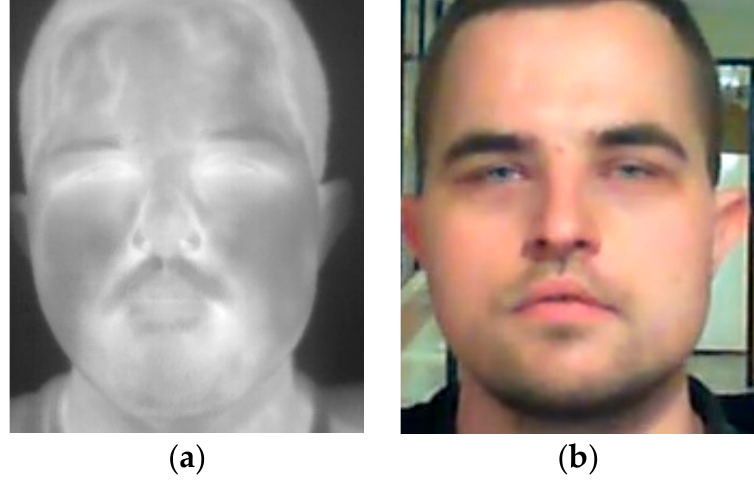
Figure 2. Sample face images from IOE_WAT dataset: ( a ) thermal infrared; ( b ) visible spectrum.